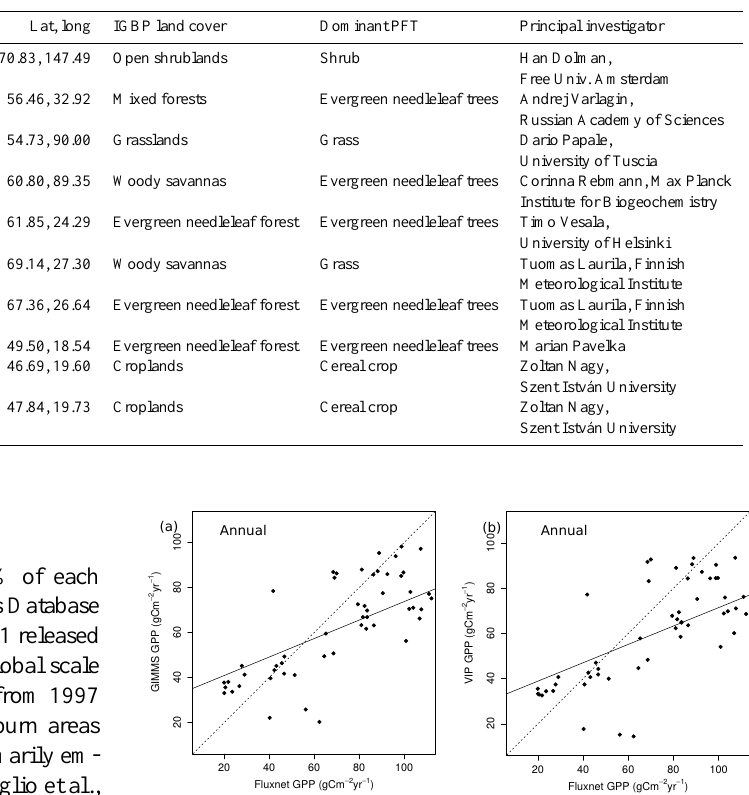
Table 2. Details of the flux towers whose GPP data have been used to validate the satellite NDVI-based GPP data. The spatial distribution of these flux towers is shown in Fig. 1.